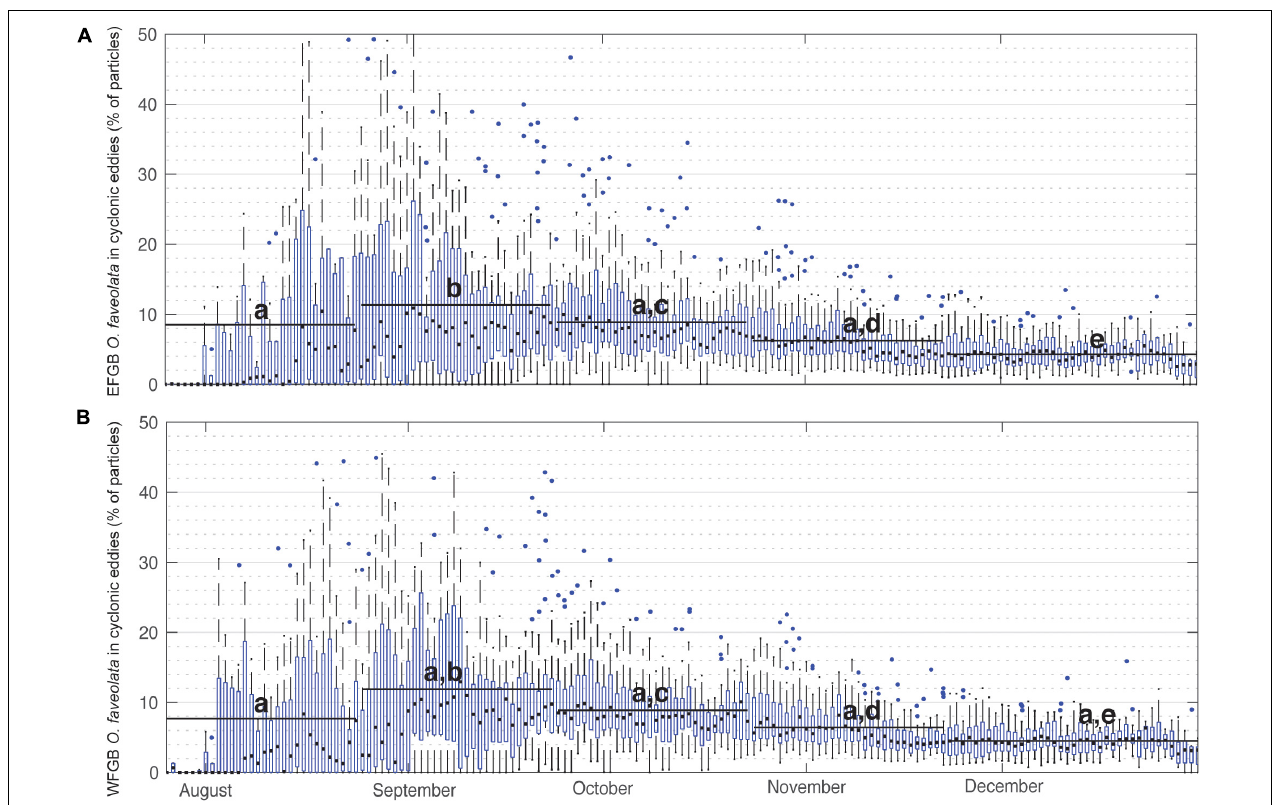
FIGURE 4 | Percentage of O. faveolata virtual larvae entrained in cyclonic eddies over time. Box plots show annual distributions across the 25 modeled spawn events (2004–2018) of the percentage of (A) EFGB and (B) WFGB O. faveolata larvae entrained in any GoM cyclonic eddy feature on that day of the year. Boxes are interquartile ranges, black lines are median values, blue circles are outliers, and whiskers represent the first and fourth quartiles. Black bars represent means taken over 30-day windows and letters correspond to significantly different pairwise comparisons (all significant differences p < 0.05, pairwise Wilcoxen tests with Benjamini and Hochberg adjusted p